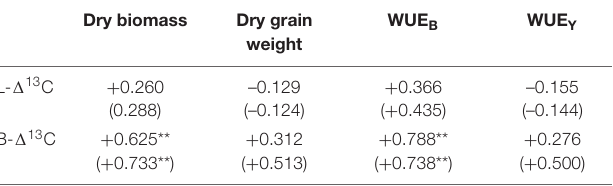
TABLE 4 | The correlation of (cid:49) 13 C with biomass and water use efficiency. Dry